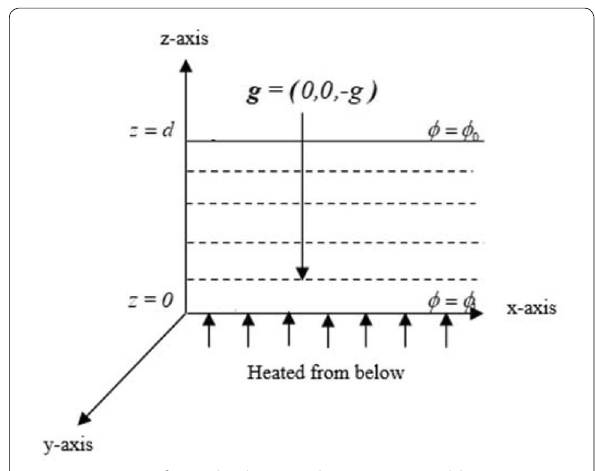
Fig.2 Geometry for Rayleigh–Bénard convection